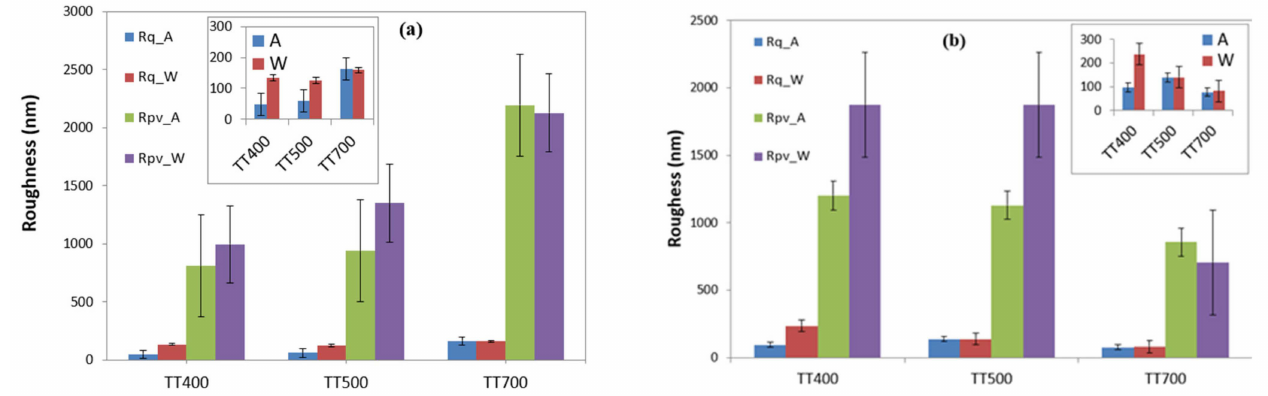
Figure 10. Roughness values inferred in the case of LiC ( a ) and LiP ( b ) coatings subjected to post- deposition thermal treatments (at different temperatures), in air and water-vapor ambient. Inset: detailed roughness